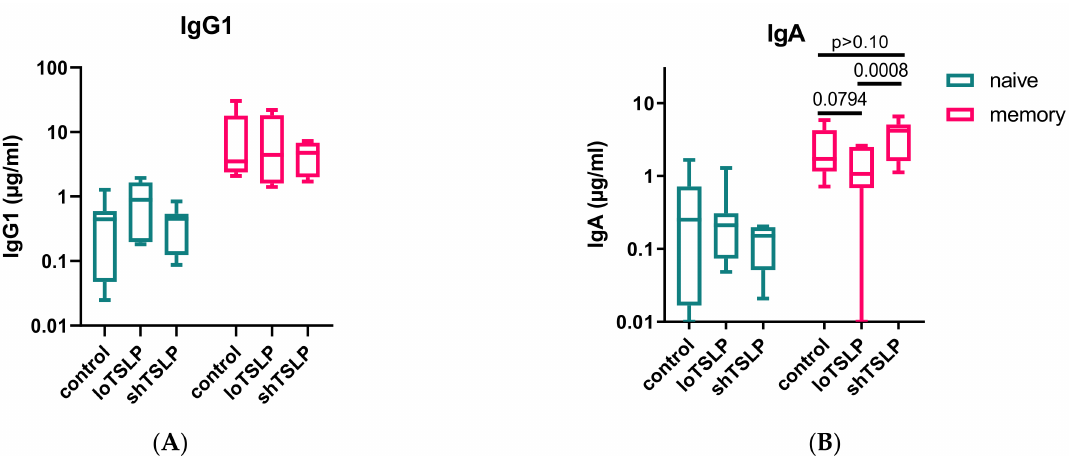
Figure 4. IgG and IgA production by naïve and memory B cells stimulated with loTSLP or shTSLP. Naïve and memory B cells were stimulated for 11 days using the T cell dependent protocol and supernatants analyzed for concentrations of IgG1 ( A ) and IgA ( B ). Boxplots show mean, second, and third (box) and first and fourth percentile of seven donors tested in two independent